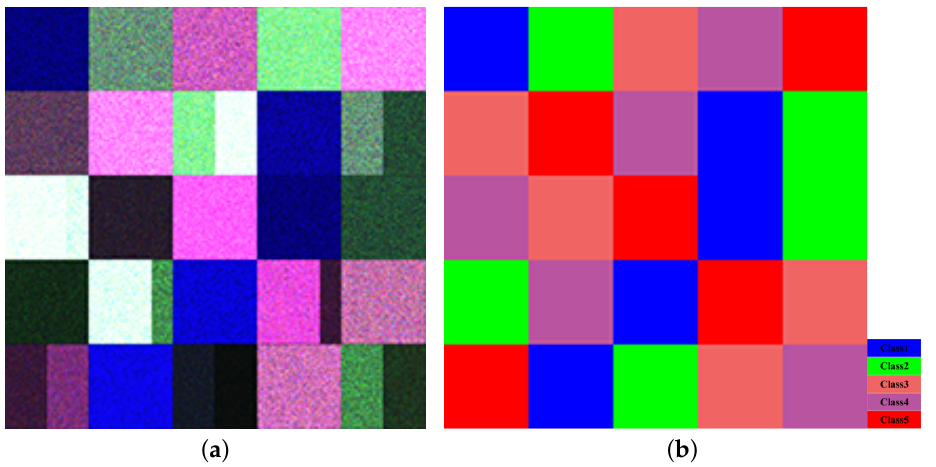
Figure 2. The simulated PolSAR images and the corresponding ground-truth maps. ( a ) Pseudocolor image of the simulated PolSAR dataset. ( b ) Ground-truth map of ( a ) (5